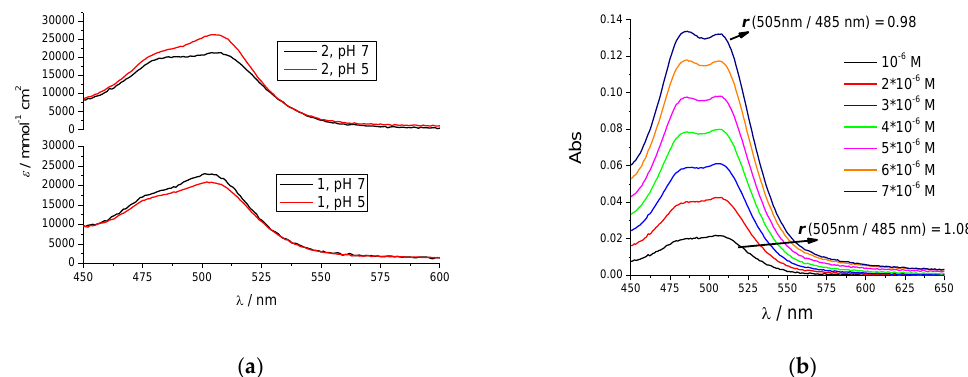
Figure 1. ( a ) The UV-Vis spectra of 1 and 2 ( c = 2 × 10 − 6 M) at pH 7.0 and pH 5.0 (sodium cacodylate buffer, I = 0.05 M). Note the difference in ratio r (505 nm/485 nm) at different pH only for 2 but not for 1 ; ( b ) The absorbance dependence on c ( 2 ); note the concentration-dependent change of ratio r (505 nm/485 nm).